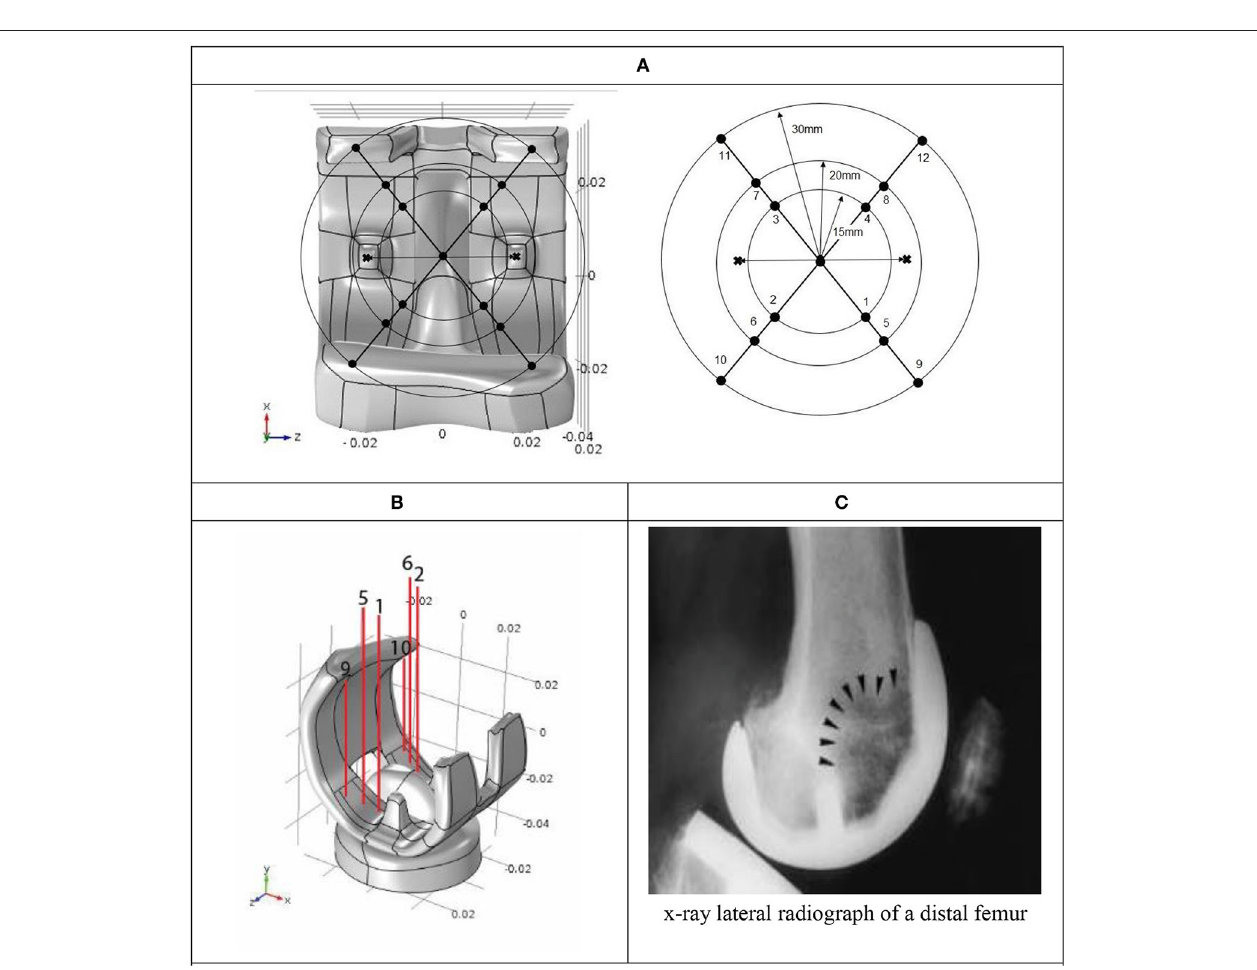
FIGURE 3 | (A) Twelve assumed directions in the prosthesis-bone system; (B) The most important directions in 3-D model; (C) The most damaged areas due to stress shielding effect based on lateral radiograph of a distal femur showing distal anterior femoral osteopenia behind the femoral component (arrowheads) (Van Loon et al.,